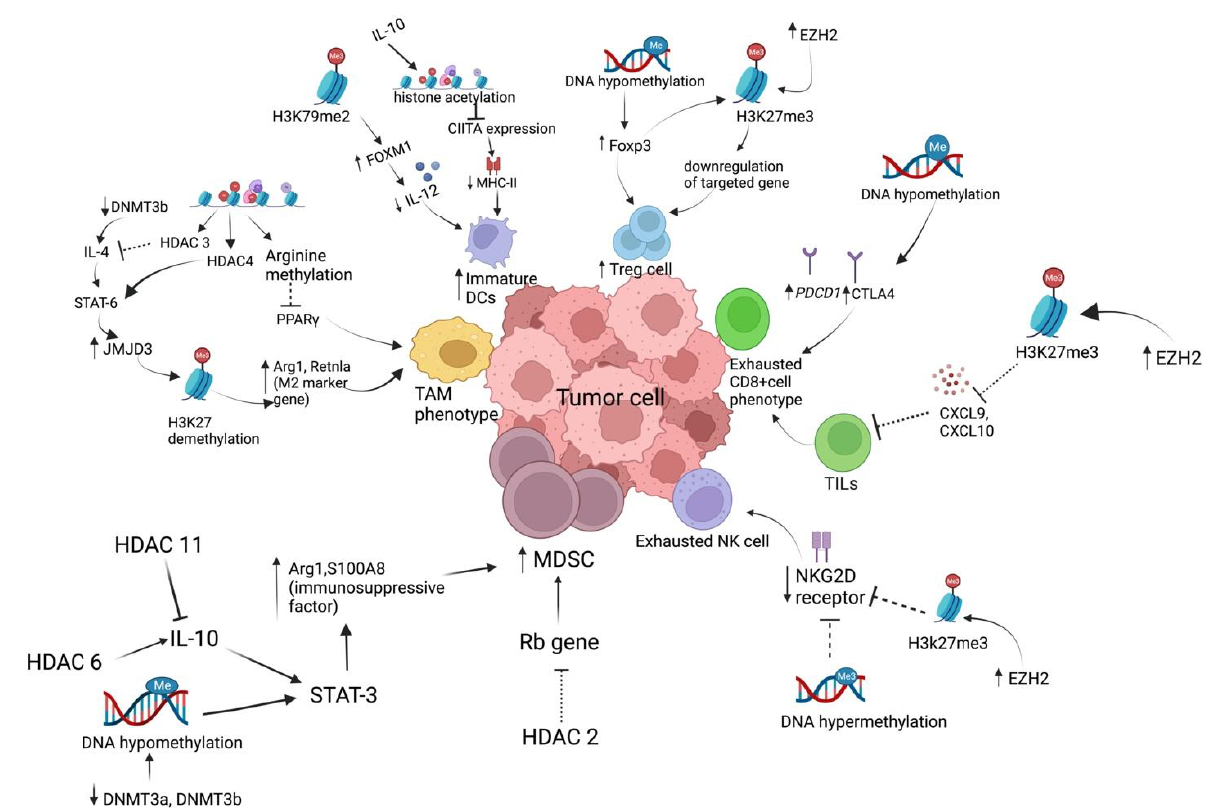
Figure 3. Epigenetic regulation of antitumor immunity. H3K79me2 mediated increased Foxp3 ex- pression associated with decreased production of IL-12, which is important for DC action. IL10-mediated histone acetylation affects type I CIITA expression (positive regulator of MHC-II). Thus, it increases the infiltration of immature DCs in TME. IL4/STAT6 mediated increase in H3K27 de- methylation responsible for enhanced expression of M2 marker gene (such as Arg1, Retnla) is asso- ciated with M2 macrophage polarization within TME. IL/10/STAT3 mediated Arg1 and S100A8 (im-